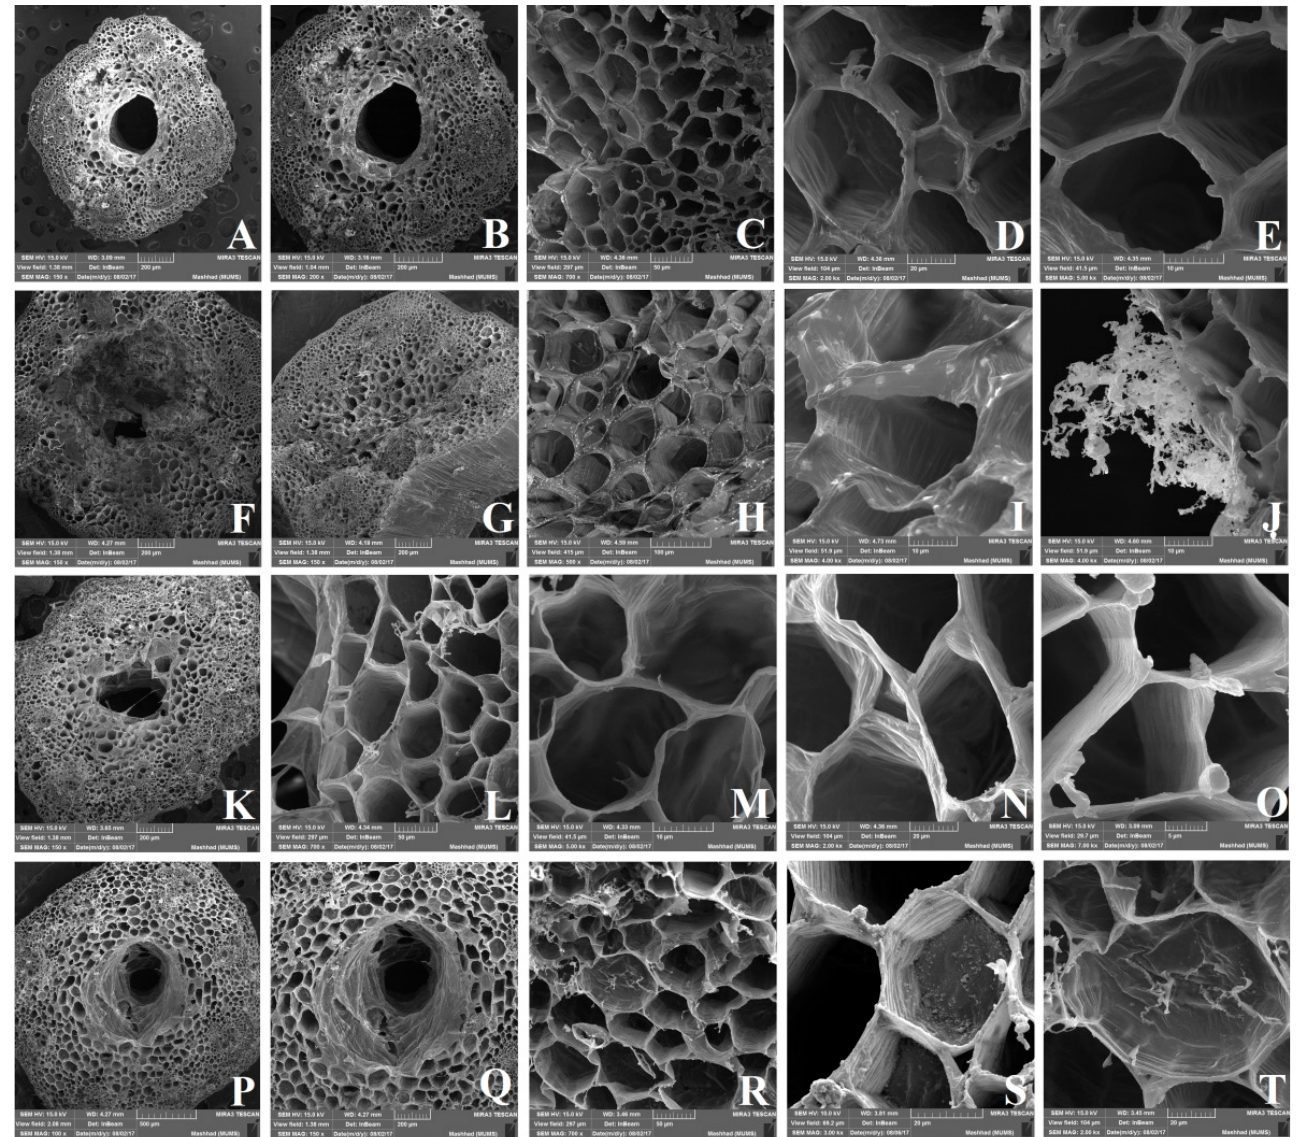
Fig. 4: The ultra-structure images are based on the electron microscopy (FESEM) for tracing the uptake of CNT in shoots of the seedlings treated by the plasma and CNT. Cross-sections of M. charantia main shoots after exposure to (A, B, C, D, and E) control, (F, G, H, I and J) functionalized CNT 200 mgl -1 , (K, L, M, N, and O) Plasma of 120 s (P, Q, R, S, and T) Plasma of 120 s + functionalized CNT 200 mgl -1 . From left to right panels represent general and detailed information, respectively, concerning selected areas.